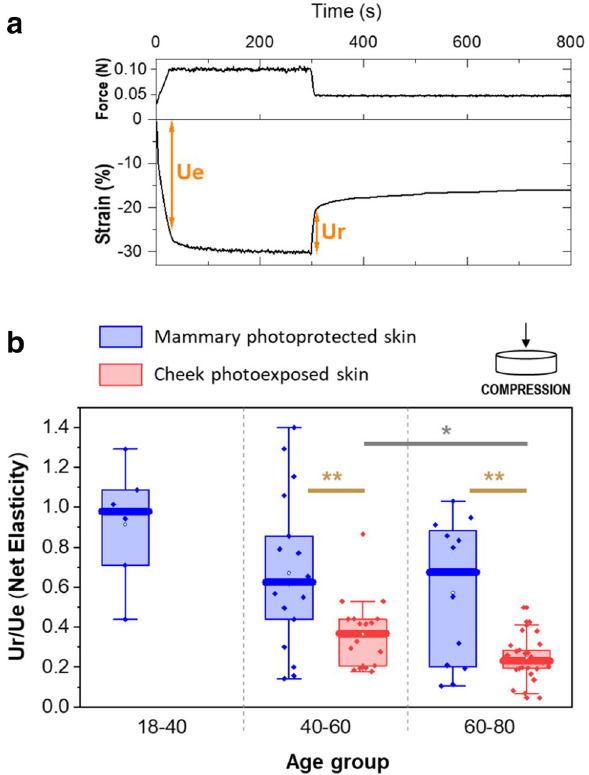
Figure 2. Elastic recoil of full-thickness skin after compressive deformation perpendicular to skin surface. ( a ) Time course of stress (upper panel) and strain (lower panel) in a typical compression experiment, together with the definition of parameters Ue and Ur (see “Materials and methods” for more details). ( b ) Net elasticity (Ur/ Ue) of photoprotected mammary (blue) and photoexposed cheek (red) skin as a function of age group. One dot represents one skin sample. Multiple samples were obtained for each donor. * p < 0.05, ** p <